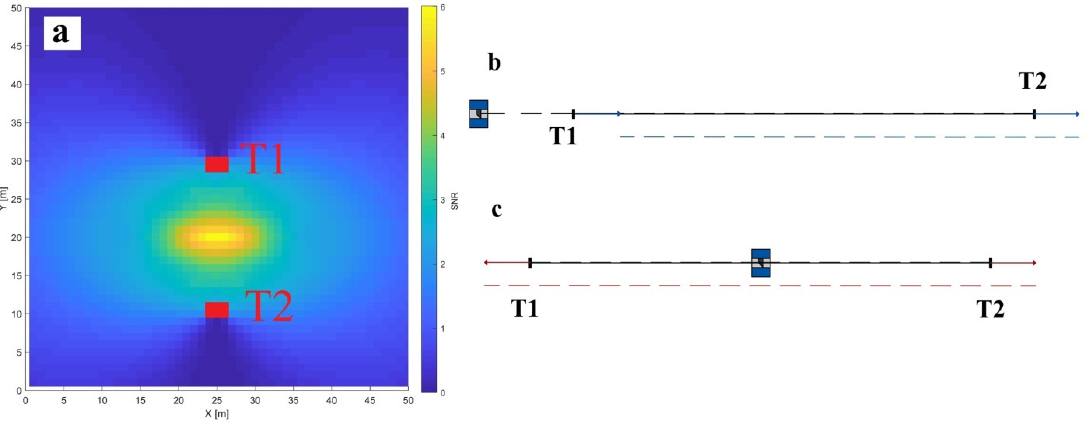
Figure 13. The SNR ratio of the length consistency test for 𝑥 (cid:2869)(cid:2868) ( a ), with the least ( b ) and the most ( c ) sensitive TLS positions (top view); line and arrows: blue—translated length, red—extended length.